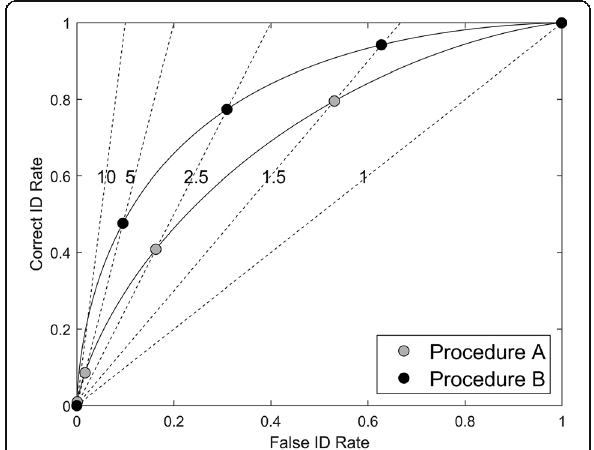
Fig. 1 Hypothetical ROC curves for two memory test procedures. Procedure B has higher empirical discriminability (AUC) than Procedure A. The dashed lines represent different diagnosticity ratios taking the values 1, 1.5, 2.5, 5 and 10. Each point on each ROC curve that intersects with a line has the corresponding diagnosticity